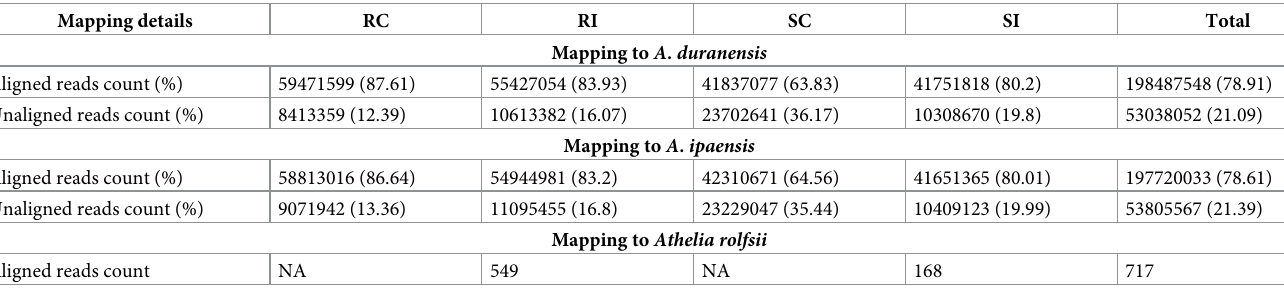
Table 2. Mapping statistics of HQRs to A . duranensis and A . ipaensis genomes. Mapping